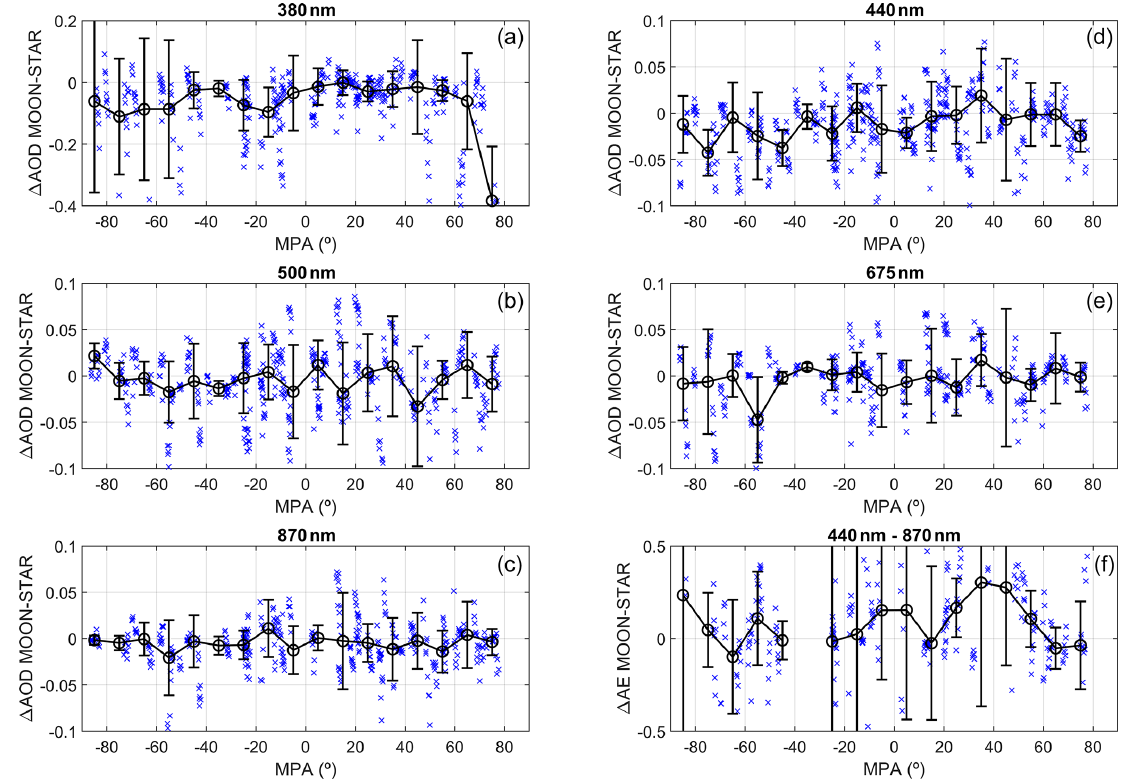
Figure 5. Aerosol optical depth (AOD) differences between the Moon and star photometers as a function of Moon phase angle (MPA) for different wavelengths. Panel (f) shows these differences for the Ångström exponent (AE) in the 440–870nm range. Black circles represent the median of all differences in a ± 5 ◦ MPA interval, while error bars indicate ± standard deviation of the data in the same